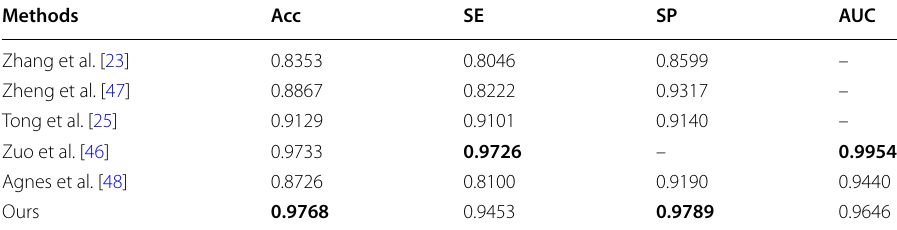
Table 3 Quantitative results of pulmonary nodule classification in which highlighted values represent the best result of each